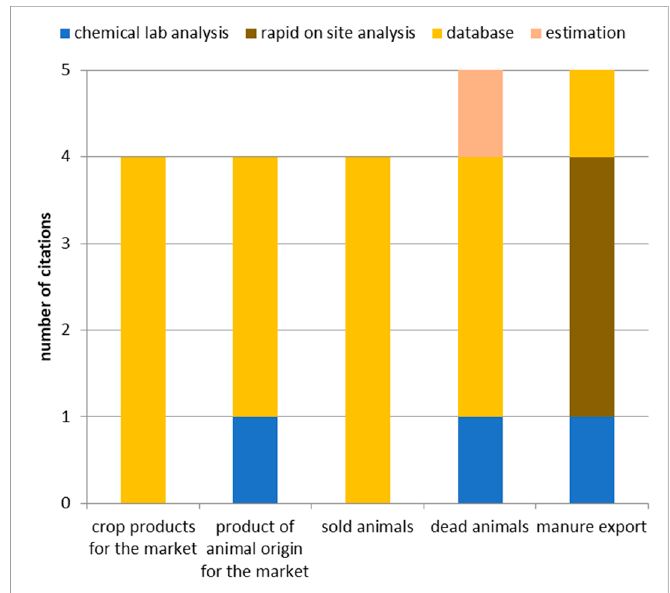
Figure 8. Qualitative determination of elements of nitrogen removal of farm budgets; multiple answers are possible (Source: expert survey results).